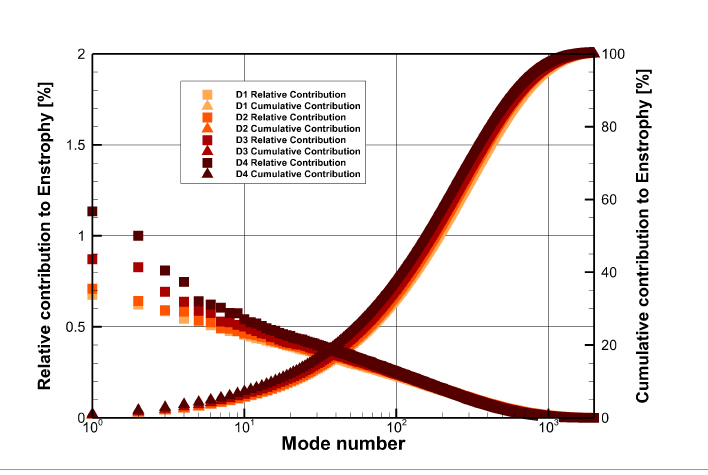
Fig. 7. The first POD modes of vorticity for the atmospheric boundary layer with variable distances of the spires ABLM4D1, ABLM4D3 and ABLM4D4, from left to right. H S is the inner height of the test section. Flow comes from left to right.